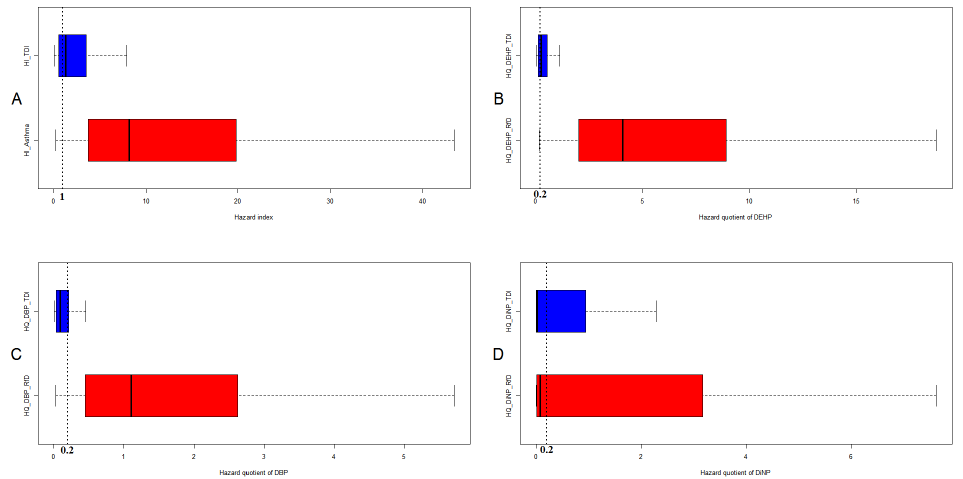
Figure 1. Comparisons of HI and HQs between RfD and TDI by boxplot. ( A ) HI ( B ) HQ DEHP ( C ) HQ DBP ( D ) HQ DiNP . A HQ of <0.2 is often considered acceptable, while a HI of <1.0 is considered acceptable.